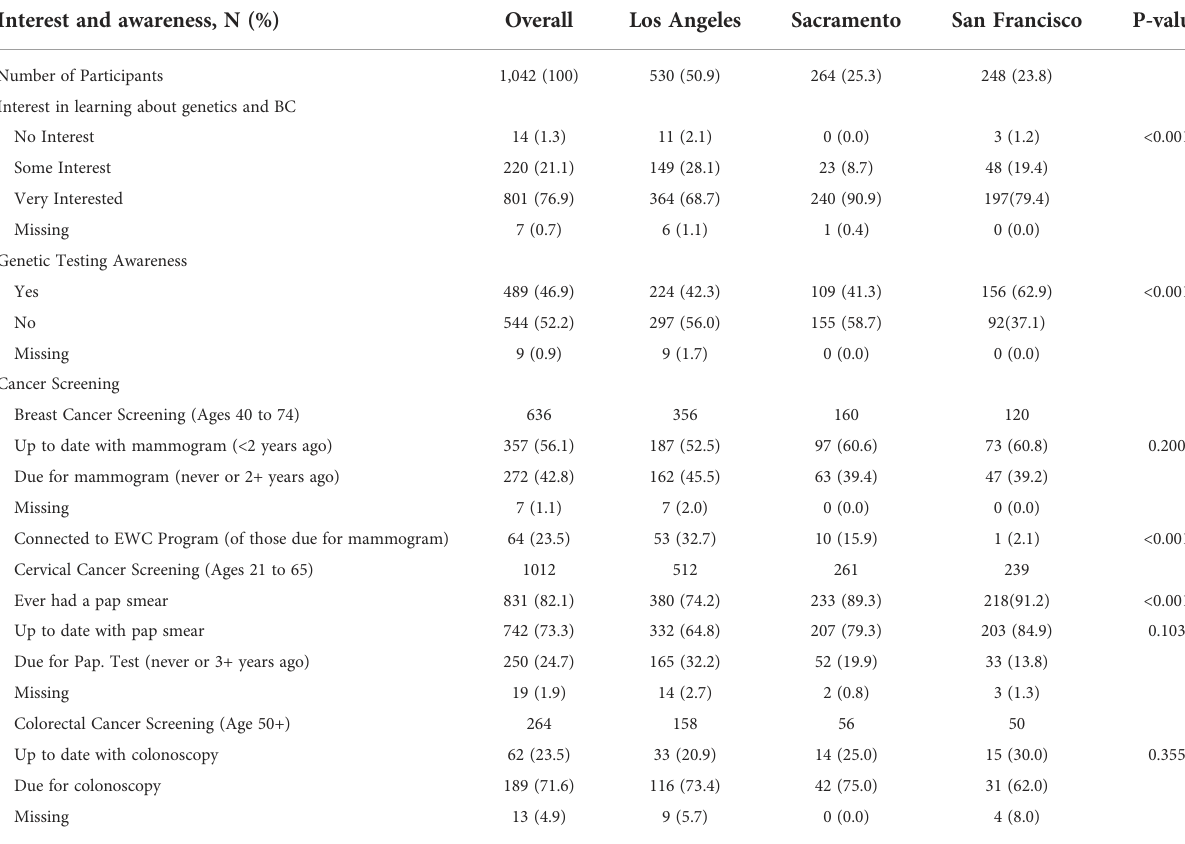
TABLE 2 Screening behavior and interest in breast cancer genetics among ‘ Tu Historia Cuenta ’ study participants (N=1,042) overall and by recruitment area. Interest and awareness, N